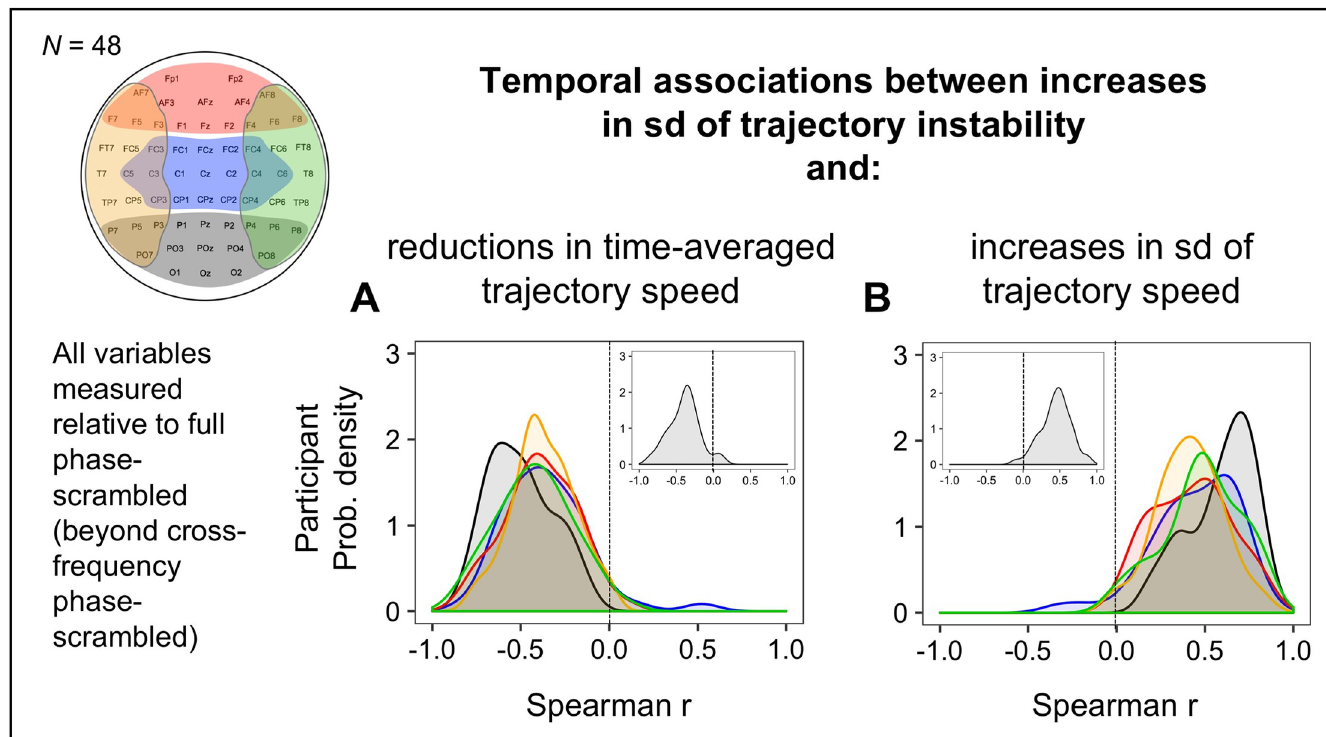
Fig 9. Temporal associations (across 5-sec time segments) between increases in the standard deviation (sd) of trajectory instability and reductions in time- averaged trajectory speed and increases in the sd of trajectory speed. All variables were measured relative to the full phase-scrambled controls (beyond the cross- frequency phase-scrambled controls) to reflect the effects of cross-site within-frequency phase relations. A. Temporal associations between increases in trajectory- instability sd and reductions in time-averaged trajectory speed. B. Temporal associations between increases in trajectory-instability sd and increases in trajectory-speed sd. Each panel shows the cross-participant distributions (as interpolated probability density functions) of Spearman r values for the five regions (posterior: black, central: blue, anterior: red, left-lateral: orange, and right-lateral: green). The insets show the corresponding distributions for EEG-state trajectories for the global non-adjacent site configuration (see Fig